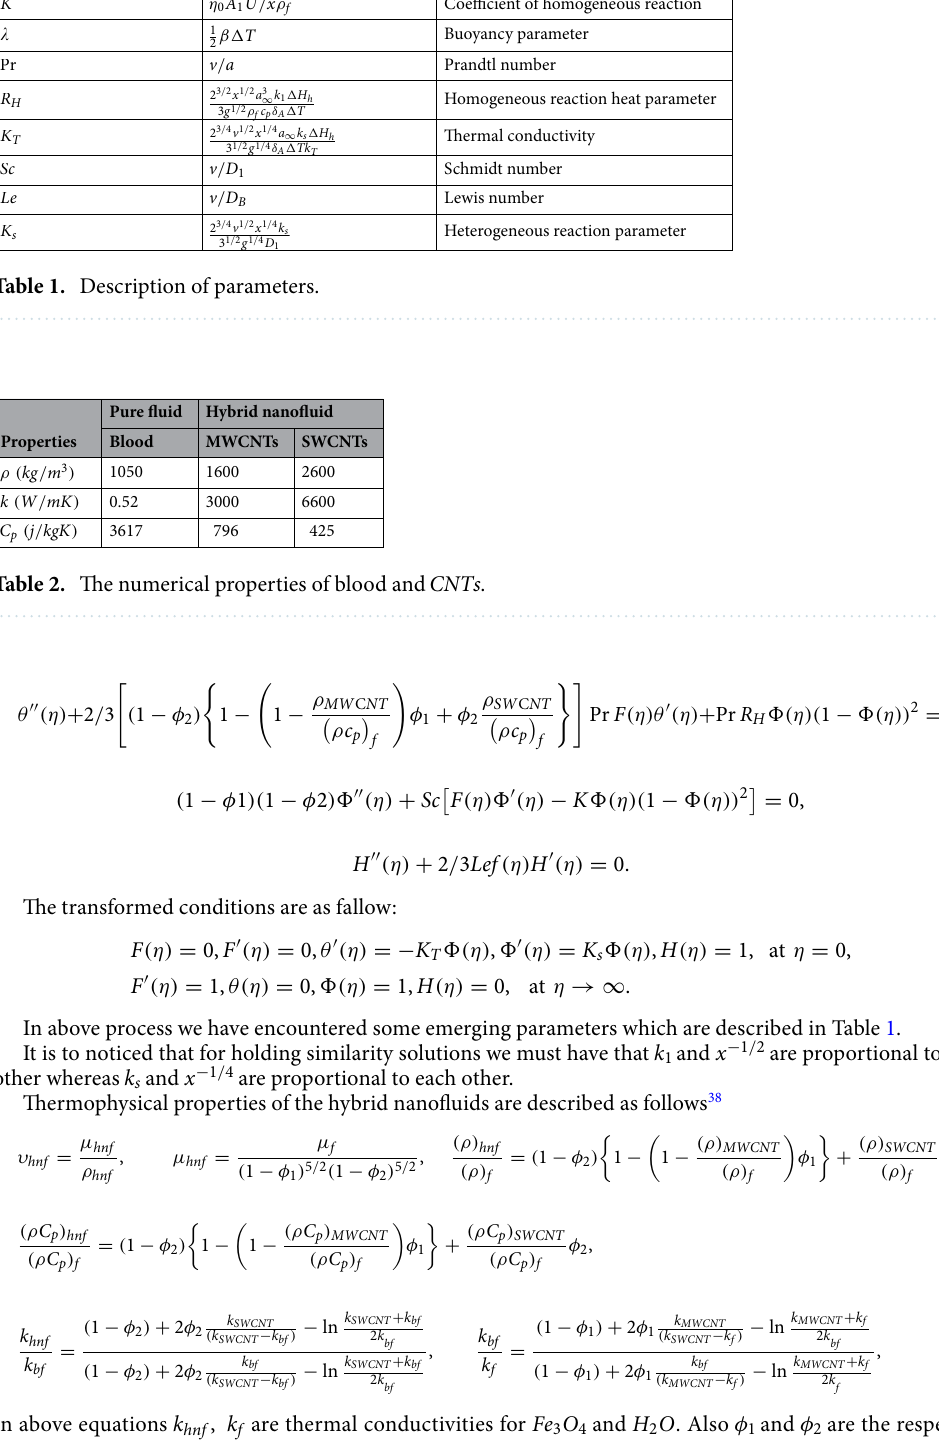
Table 2. Required physical quantities. The skin-friction coefficient C number Sh x are given mathematically as: